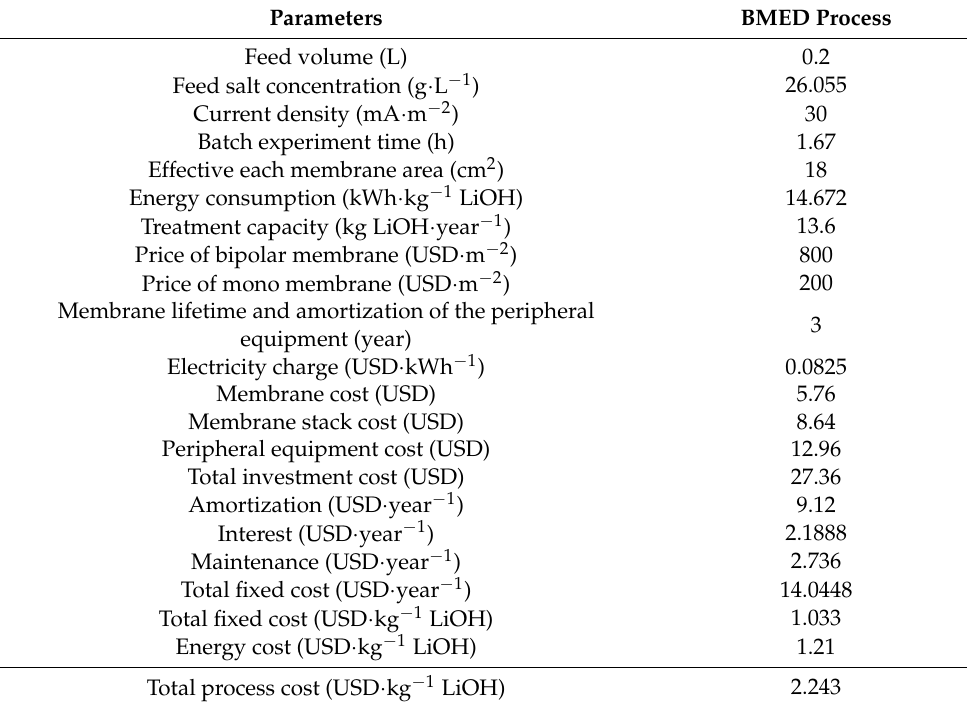
Table 2. Economic analysis of BMED treatment of lithium